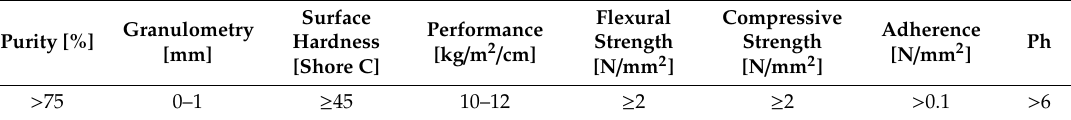
Table 1. Properties of B1 gypsum used as base material.